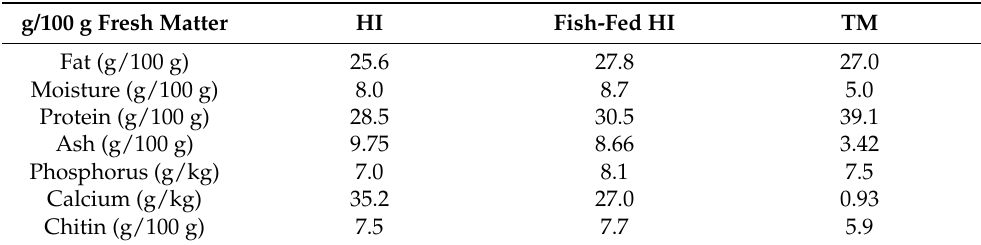
Table 1. Proximal composition of fresh insect meal.